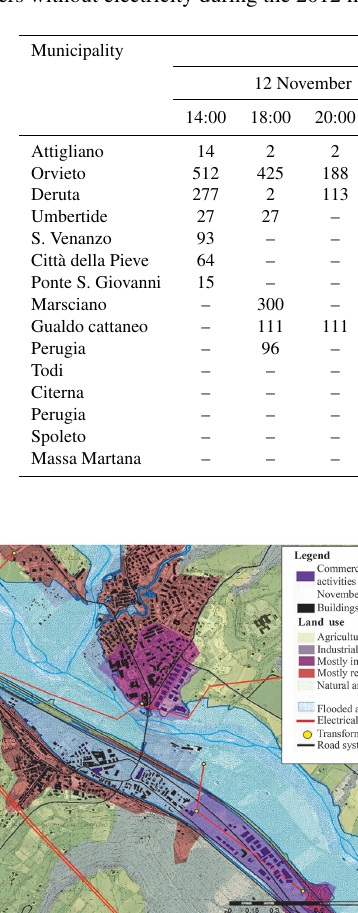
Table 3. Customers without electricity during the 2012 flood in Umbria: temporal evolution per municipality.